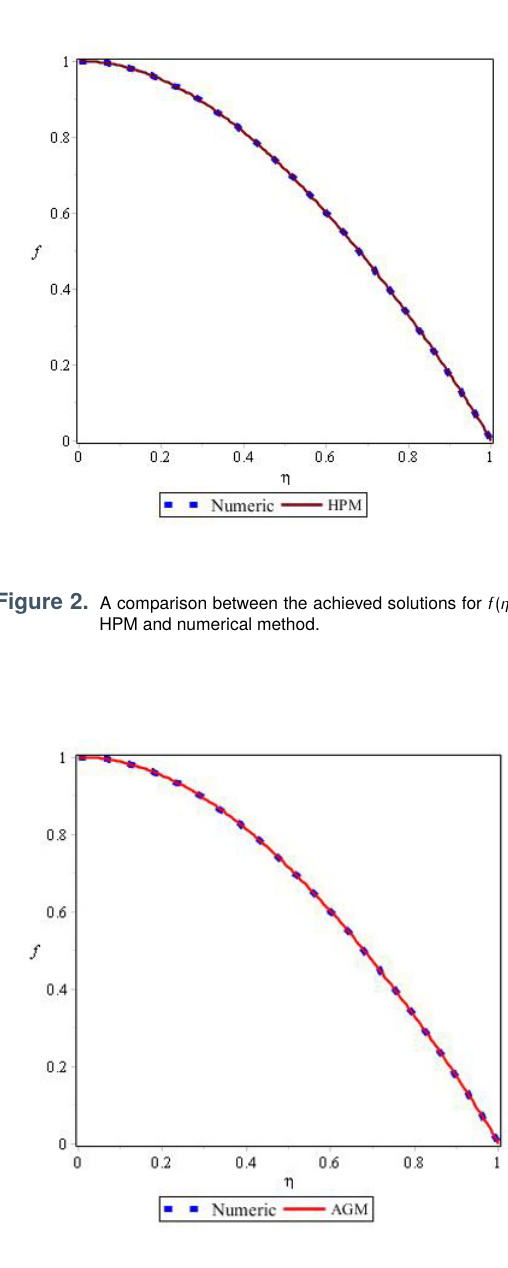
Figure 3. A comparison between the achieved solutions for f AGM and numerical